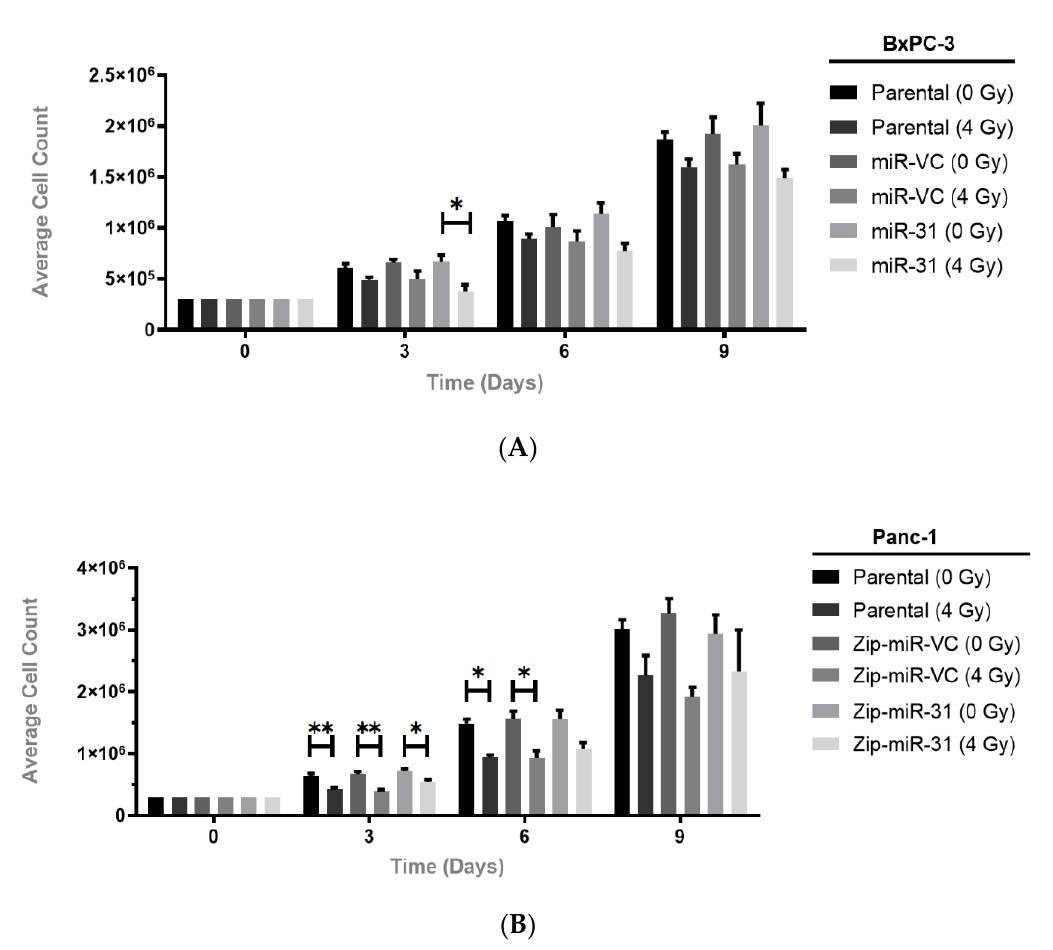
Figure 4. Manipulating miR-31 alters cell proliferation post-radiation treatment. ( A ) Assaying cumulative proliferation with radiation treatment revealed no significant decrease in cell count at any time points measured in BxPC-3-miR-VC irradiated cells (4 Gy) compared to mock-irradiated cells (0 Gy). MiR-31-expressing irradiated cells displayed a significant decrease in cell count at day 3 (* p = 0.0353) compared to their mock-irradiated counterpart. ( B ) A significant reduction in cell count was displayed at day 3 (** p = 0.00122) and day 6 (* p = 0.0120) in Panc-1 Zip-miR-VC irradiated cells compared to mock-irradiated cells, while Zip-miR-31 irradiated cells displayed a reduction in cell count at day 3 only (* p = 0.0354) compared to mock-irradiated cells. Data are expressed as the mean ± SEM ( n = 3). Two-way ANOVA with Tukey’s post-hoc test was adopted